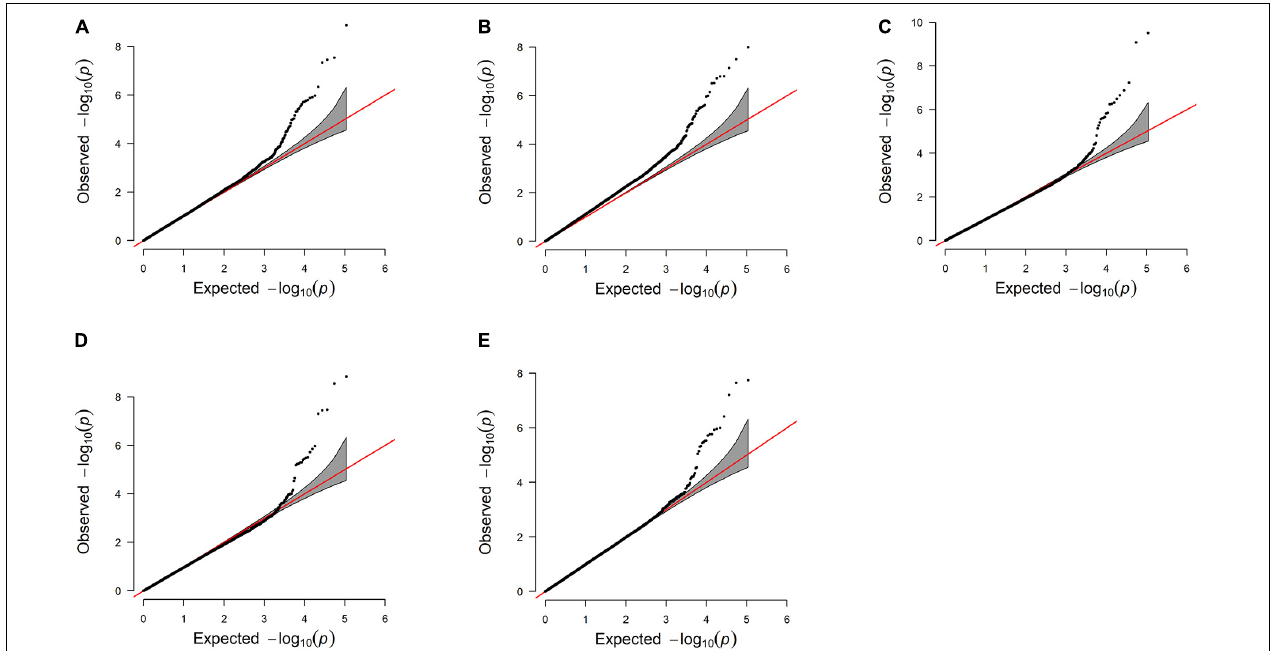
FIGURE 1 | Quantile–quantile plots of the genome-wide association studies for genetic effect of service sire on reproductive traits (A–E) . The x -axis and the y -axis represent the expected and observed − log 10 ( P − value ) , respectively. (A) Conception rate—the λ value is 1.06. (B) 56-day non-return rate—the λ value is 1.15. (C) Calving ease—the λ value is 0.96. (D) Stillbirth—the λ value is 0.95. (E) Gestation length—the λ value is 0.99.